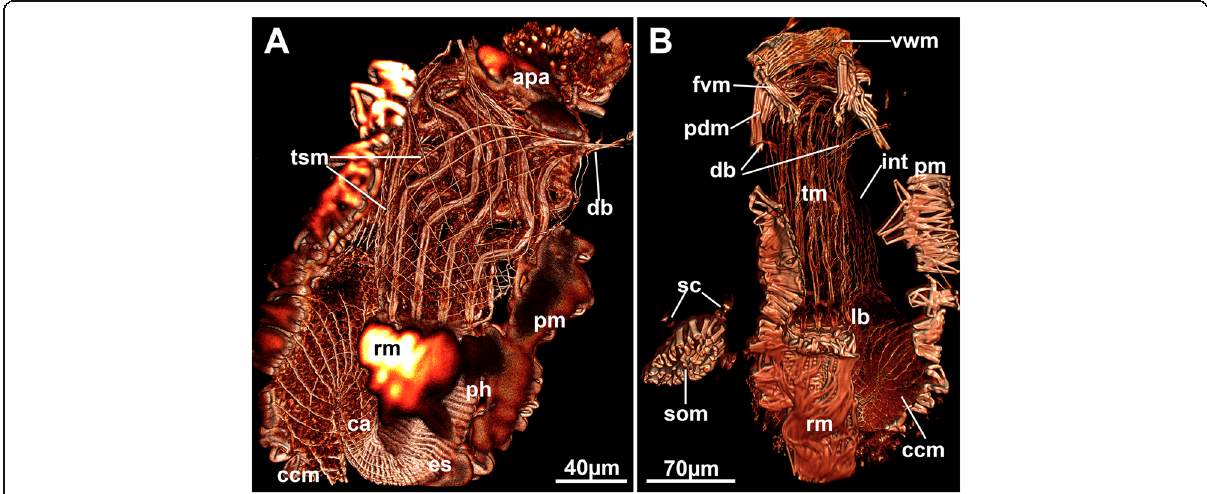
Fig. 9 General overview of the muscular system of Hypophorella expansa . f-actin staining, CLSM. a Overview of an autozooid showing musculature of the caecum and the basket covering the tentacle sheath. b Autozooid showing broad parietal musculature and longitudinal muscle fibres of the intestine. Abbreviations: apa – apertual area, ca – cardia, ccm – caecal musculature, db – duplicature band, es – esophagus, fvm – frontal vestibular muscles, int – intestine, lb. – lophophoral base, pdm – parieto-diaphragmatic muscles, ph – pharynx, pm – parietal muscles, rm. – retractor muscles, sc – stolonal capsule, som – stolonal transverse muscle, tm – tentacle muscles, tsm – tentacle sheath muscles, vwm – vestibular wall